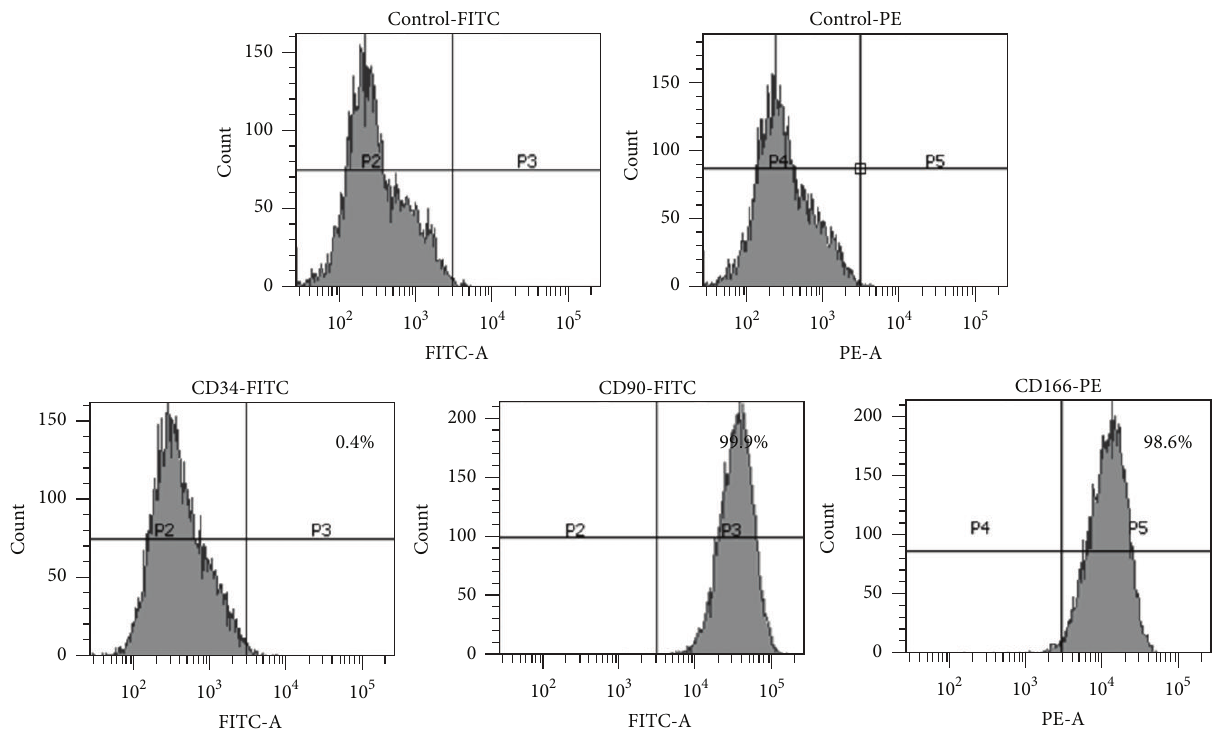
Figure 1: Cell-surface marker expression of hTMSCs using CD34 (negative) and CD90 and CD166 (positive) for confirming their stemness properties as